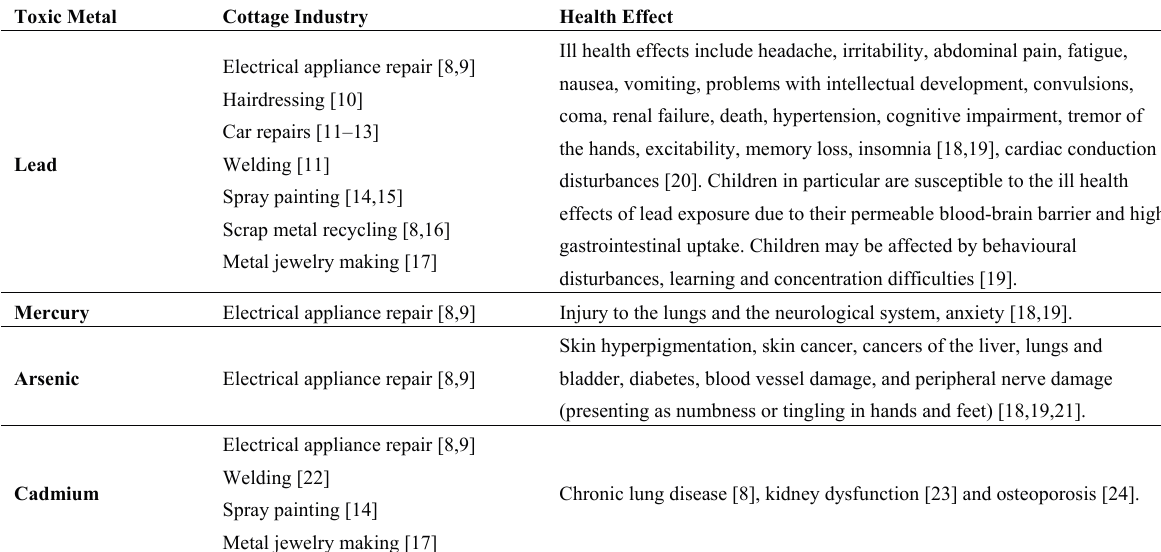
Table 1. Toxic metals and concomitant health effects associated with type of cottage